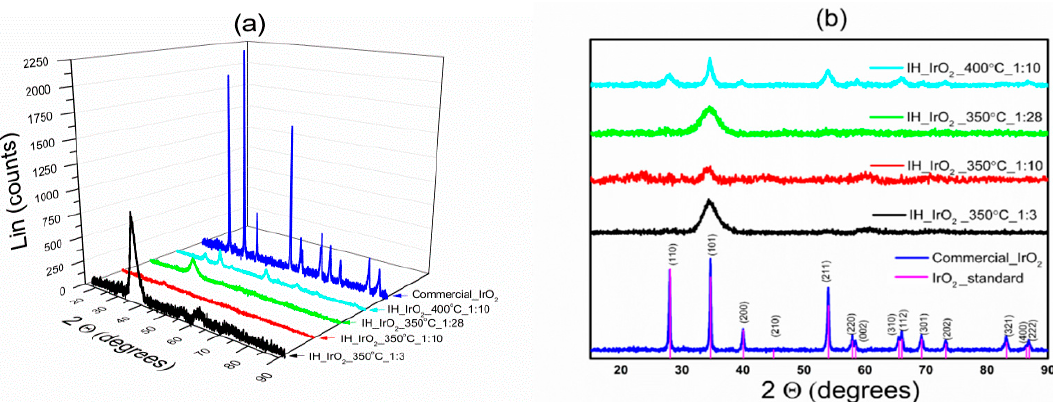
Figure 1. ( a ) 3-D plot of X-ray diffraction (XRD) patterns for in-house IrO 2 and commercial IrO 2 . ( b ) 2-D plot of XRD patterns for in-house IrO 2 and commercial IrO 2 . Table 1. Average particle/crystallite sizes for the in-house and commercial IrO 2